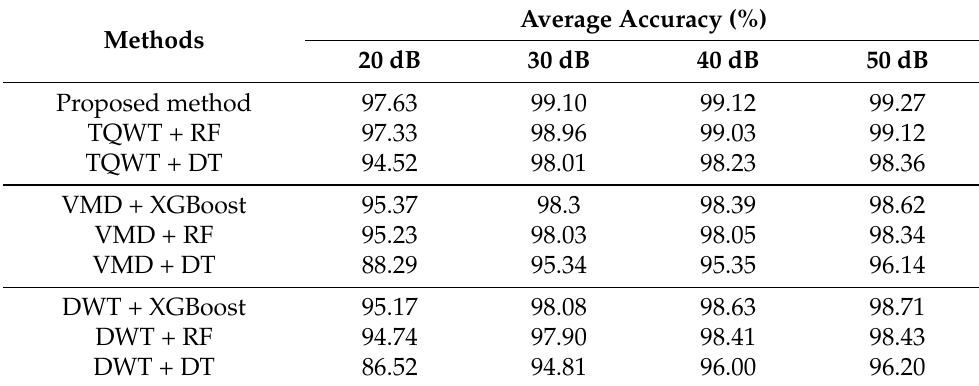
Table 3. Performance comparison of proposed method with other combination methods.